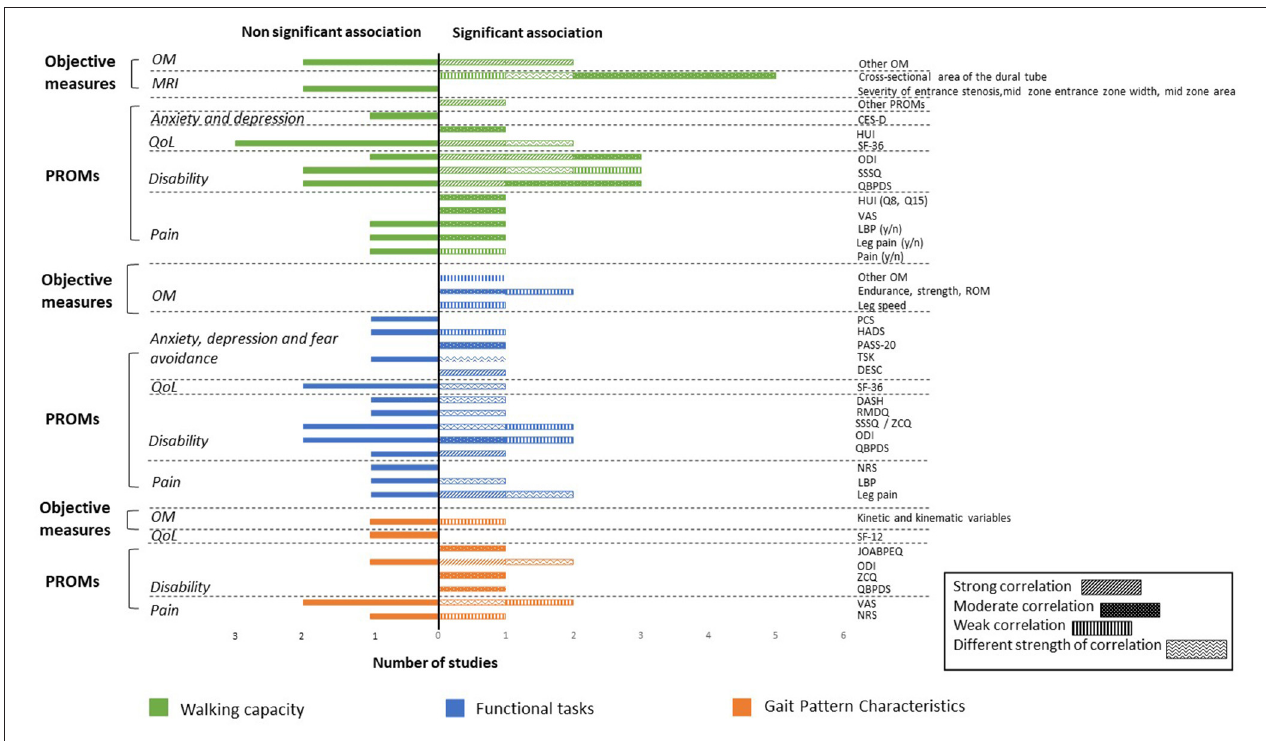
FIGURE 3 | Associations between walking capacity, gait pattern characteristics, functional tasks, and PROMs and objective measures expressed in number of studies. PROMs, Patient-Reported Outcome Measures; OM, Objective Measures; QoL, Quality of Life; MRI, Magnetic Resonance Imaging; CES-D, Center of Epidemiological Studies Depression Scale; HUI, Health Utilities Index Mark 3; SF-36, 36-item Short Form Health Survey; SF-12, Medical Outcomes Short-Form 12; ODI, Oswestry Disability Index; SSSQ, Swiss Spinal Stenosis Questionnaire; ZCQ, Zurich Claudication Questionnaire; QBPDS, Quebec Back Pain Disability Scale; LBP, Low Back Pain; VAS, Visual Analog Scale; ROM, Range of Motion; PASS-20, Pain Anxiety Symptoms Scale; PCS, Pain Catastrophizing Scale; HADS, Hospital Anxiety and Depression Scale; TSK, Tampa Scale of Kinesiophobia; DESC, Rasch-based Depression Screener; DASH, Disability of the Arm, Shoulder and